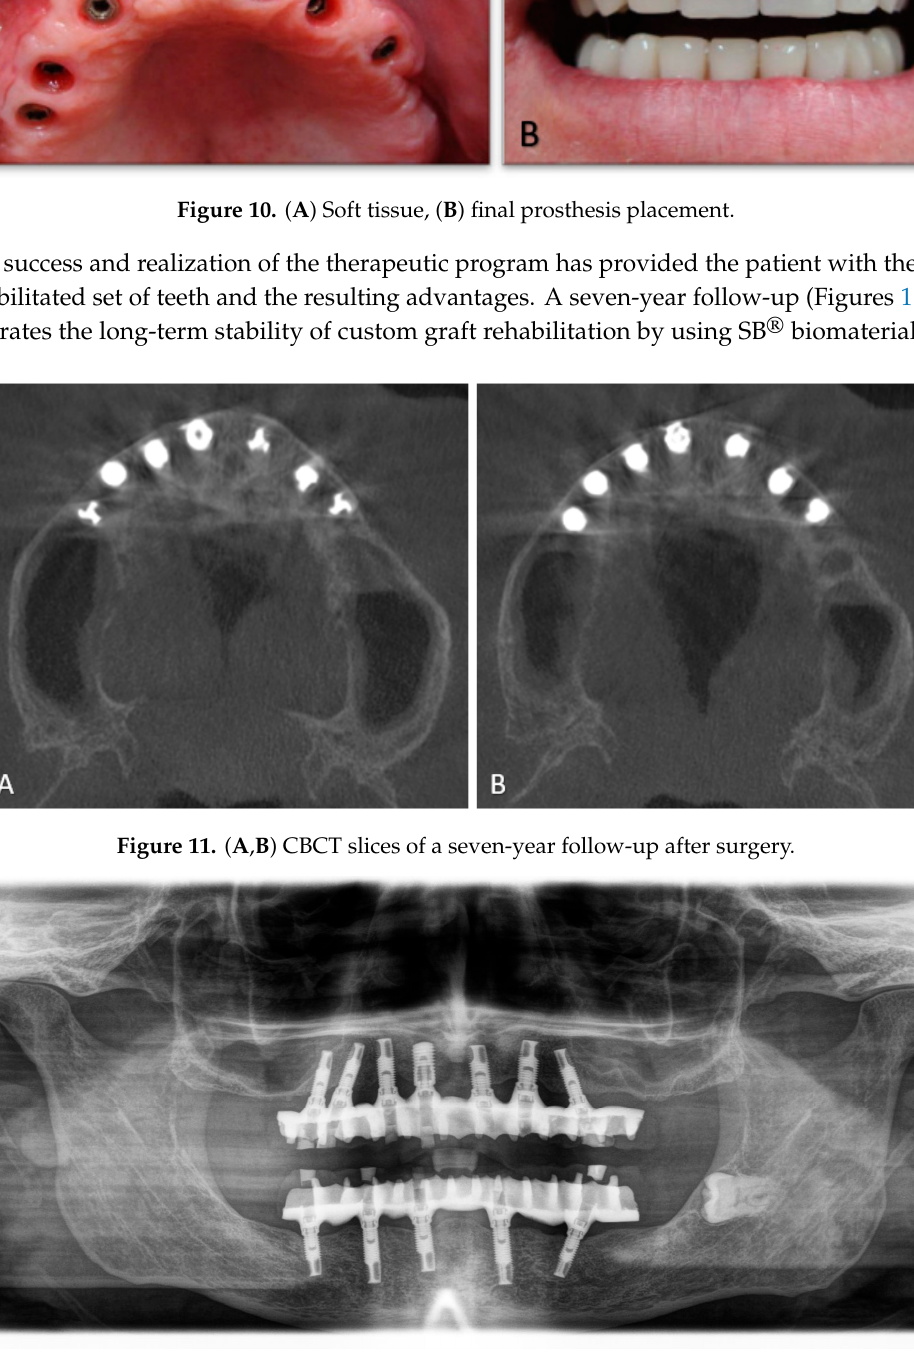
Figure 12. orthopantomogram (OPG), a seven-year follow-up after surgery.